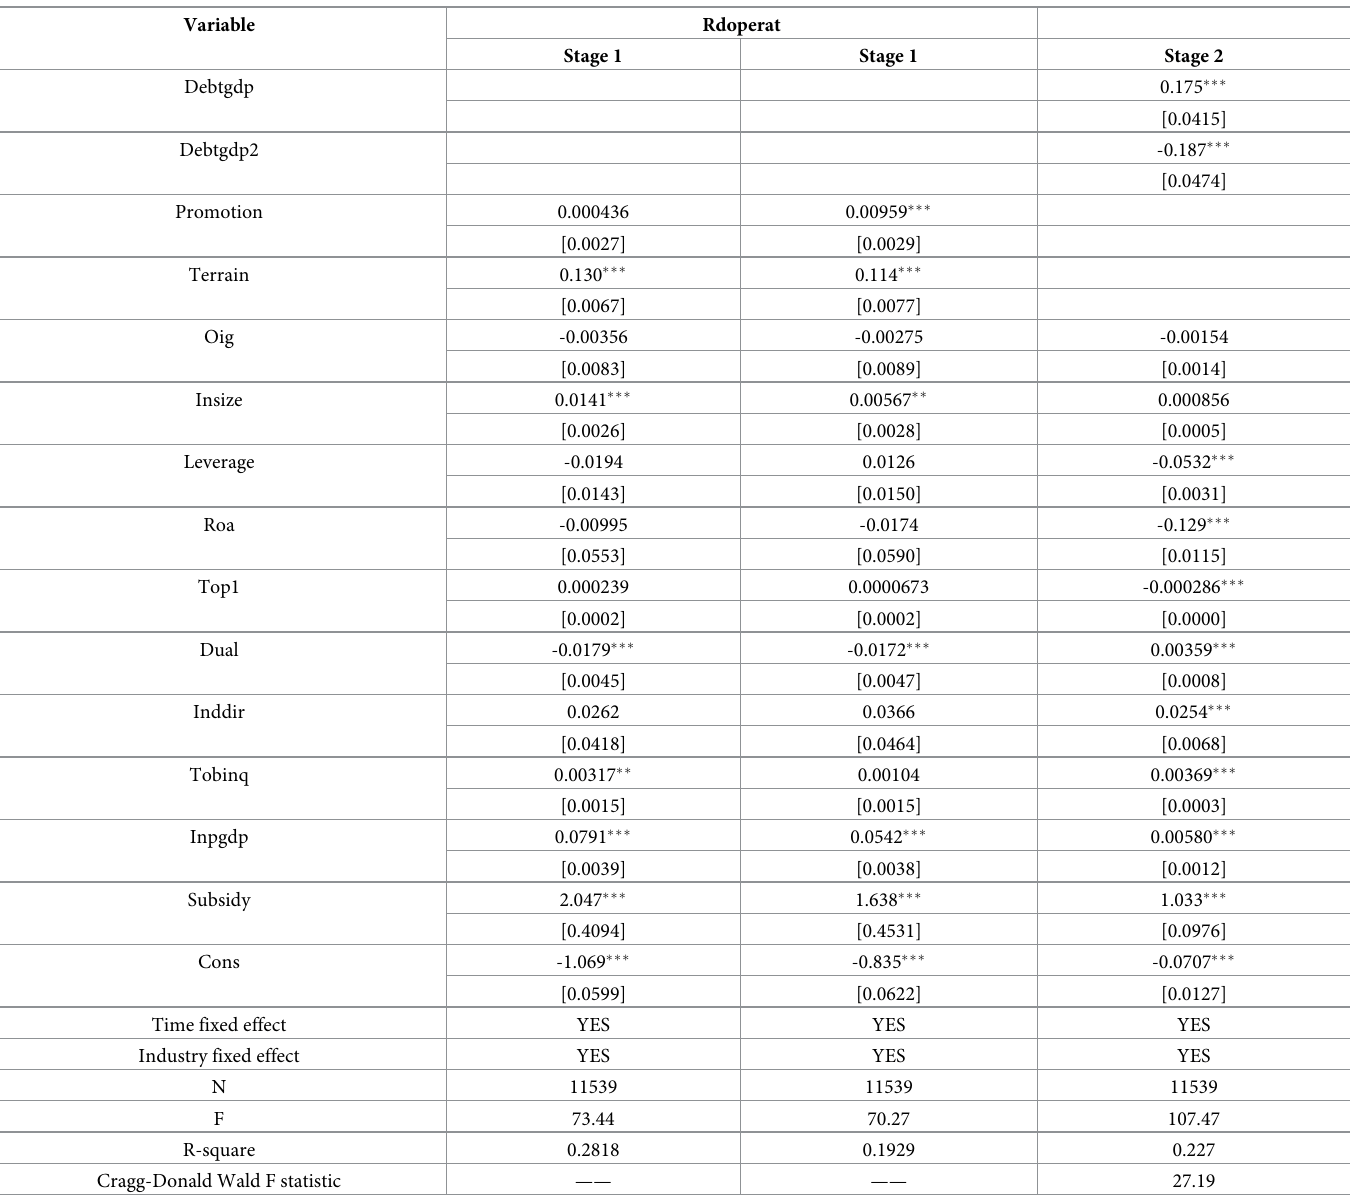
Table 3. Endogeneity test: Regression results via